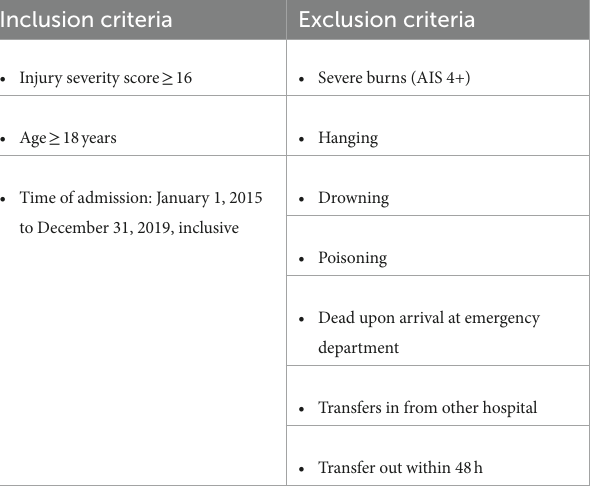
TABLE 2 Inclusion and exclusion criteria for this comparative